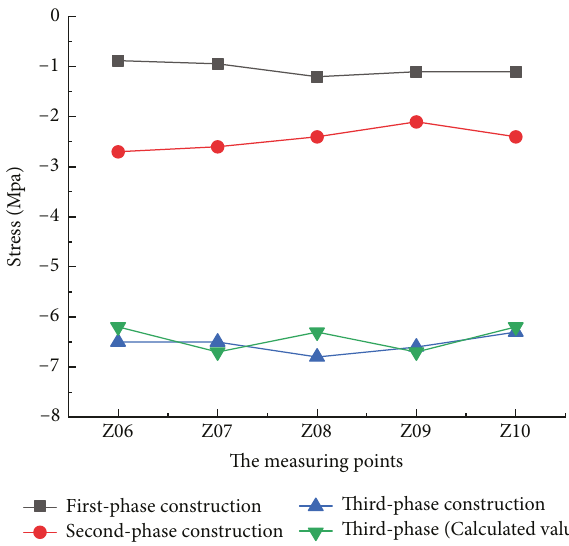
Figure 12: Stress increment comparison of the mid-span section.